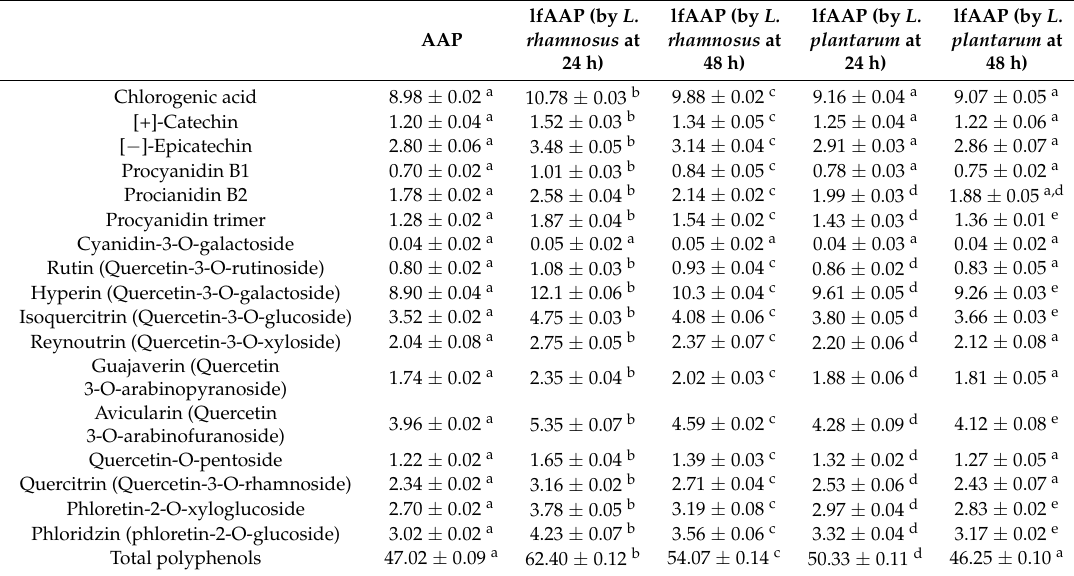
Table 1. Polyphenolic composition of Annurca apple puree (AAP) and its lactofermented versions (lfAAP) obtained by incubation (at room temperature) with different Lactobacillus strains at different times.